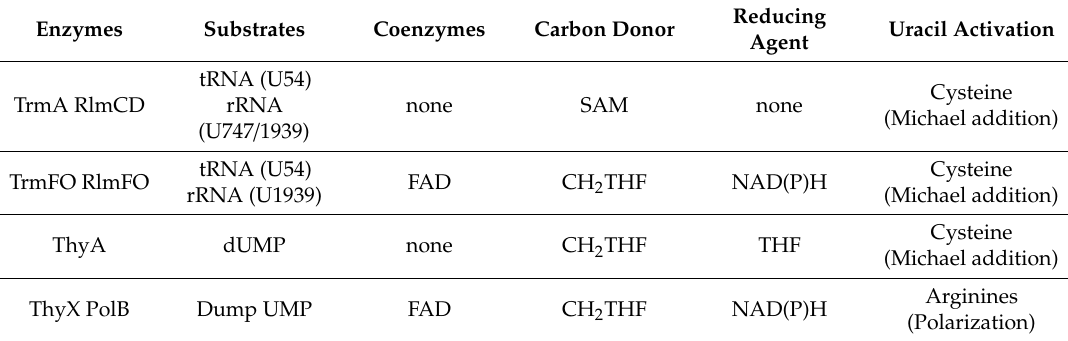
Table 1. Di ff erent enzyme families and mechanisms of